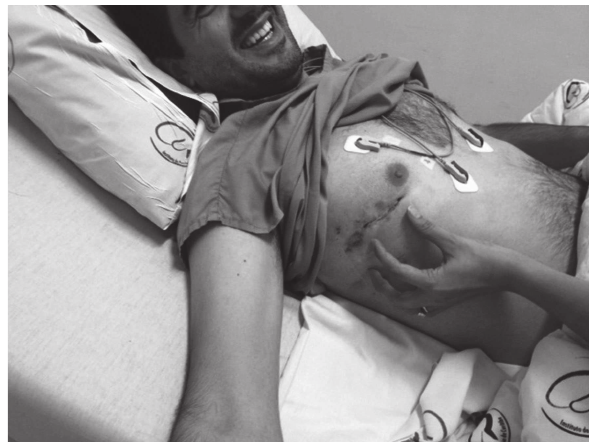
Fig. 2 – Paciente demonstra satisfação com os resultados cosméticos